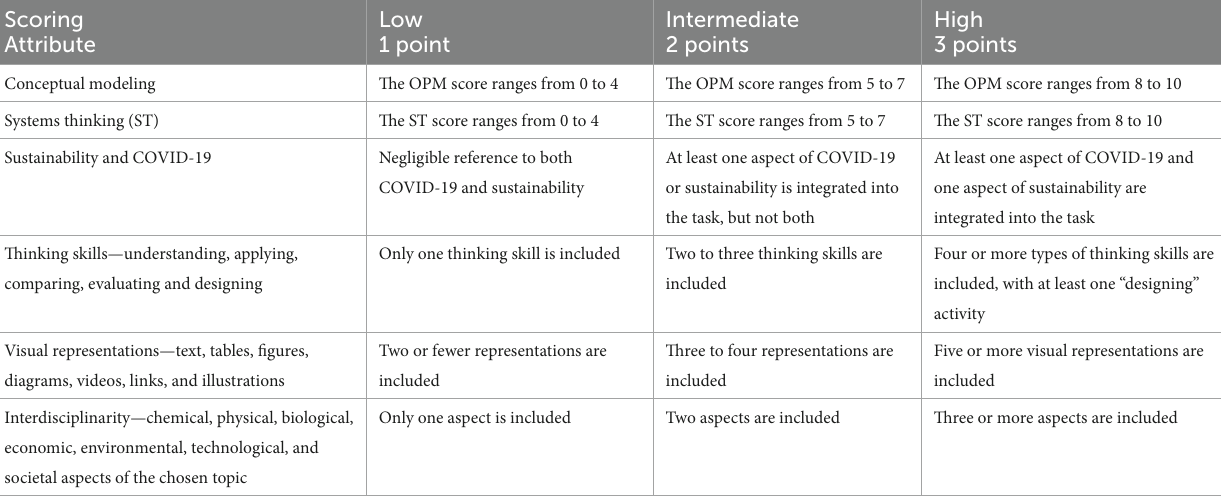
TABLE 4 Scoring rubric for the assignments developed by the teachers. Scoring